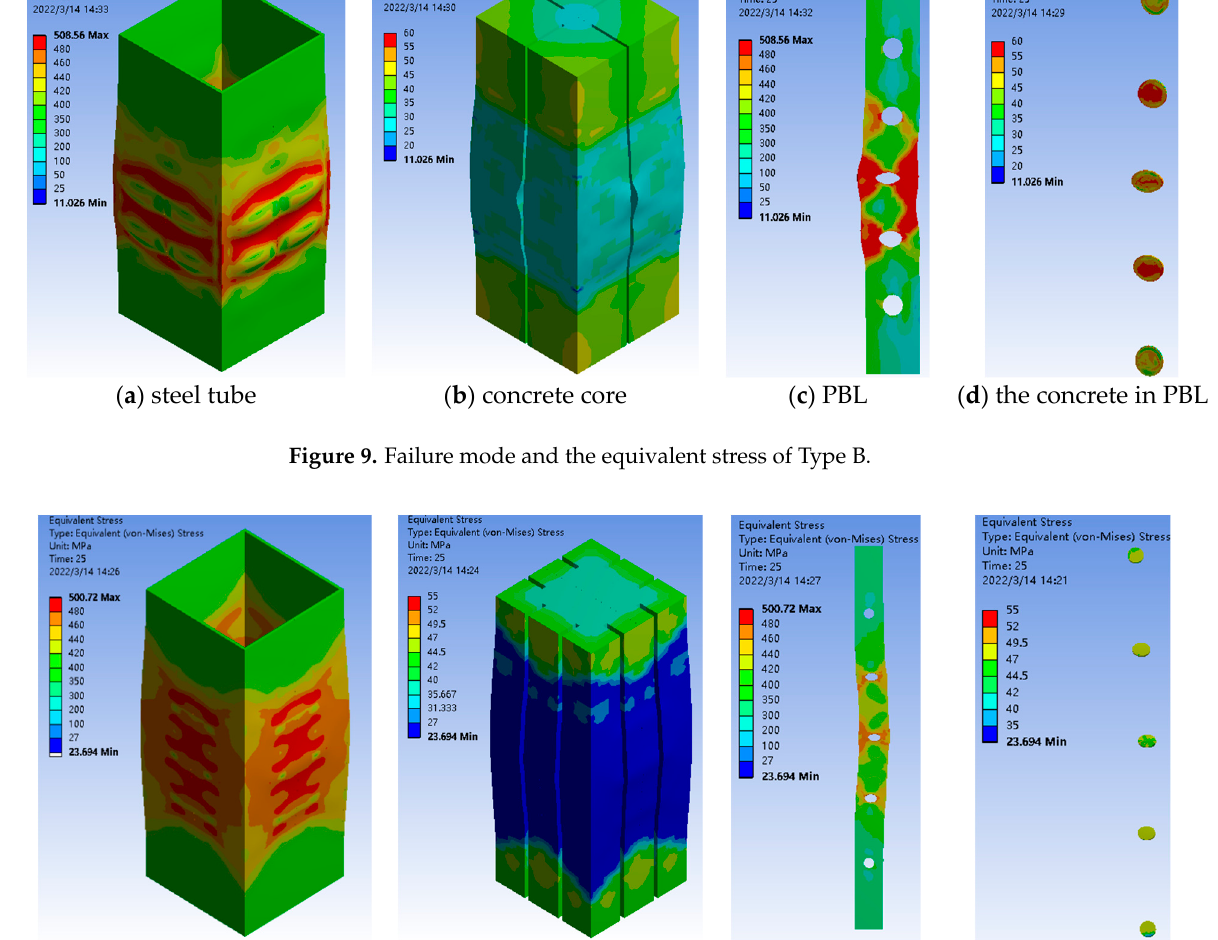
Figure 10. Failure mode and the equivalent stress of Type C.